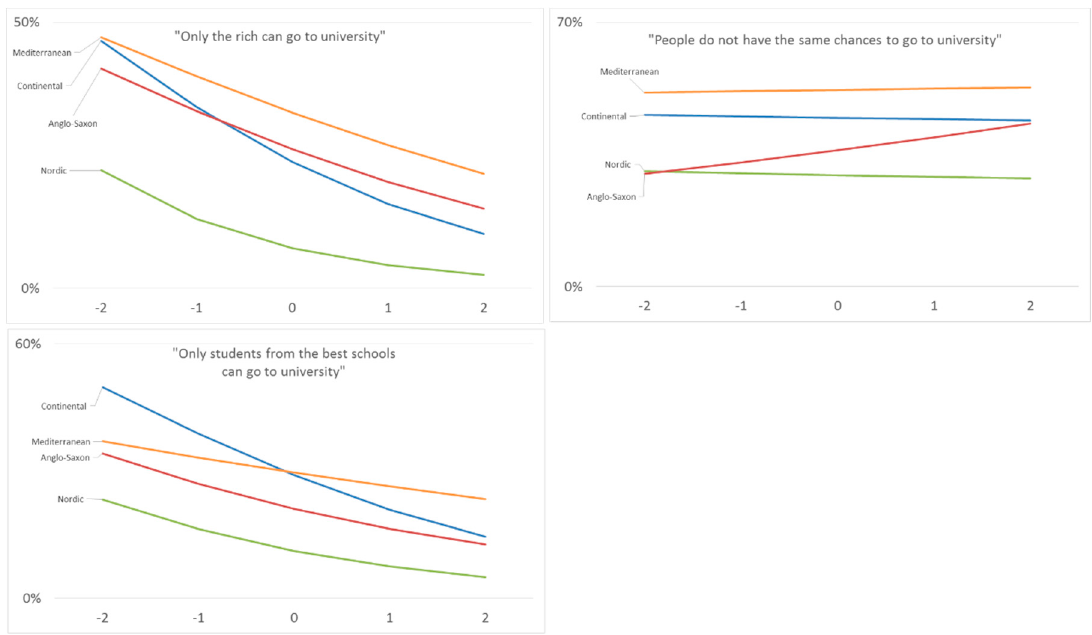
Figure 6. Perceived inequity in university access, according to educational level (standardized years of schooling).